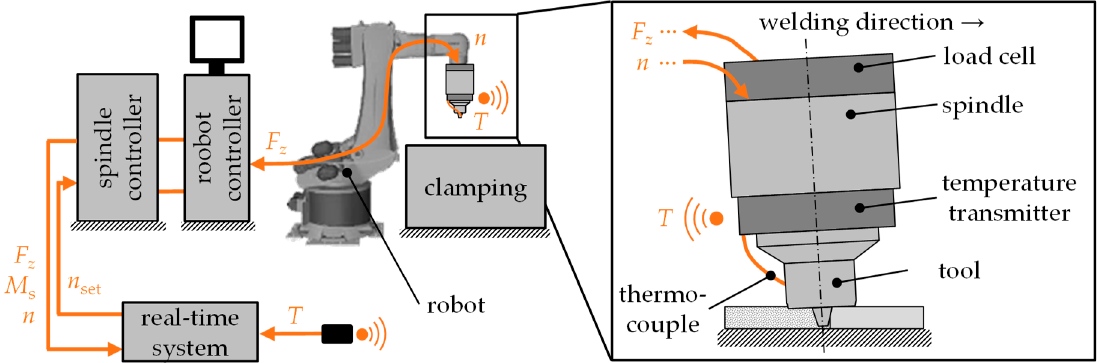
Figure 3. Experimental set-up based on [6]; a close-up photograph of the tool and the temperature transmitter is given in Figure A1 in the Appendix transmitter is given in Figure A1 in the appendix.